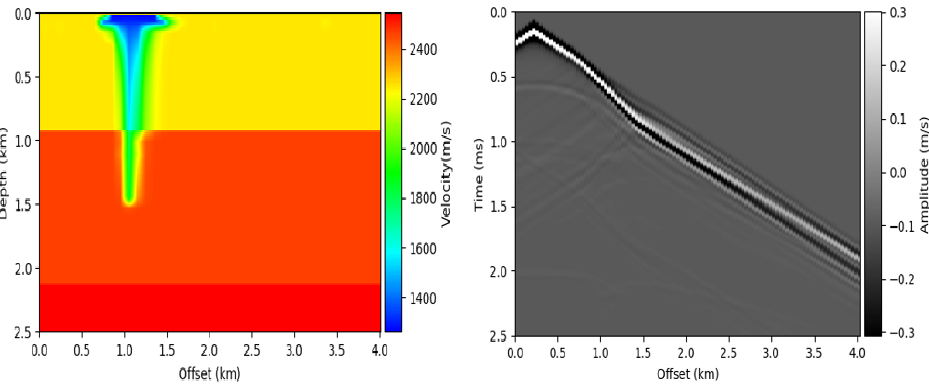
Figure 3. Sample velocity model ( left ) and seismic data ( right ) of the Kimberlina